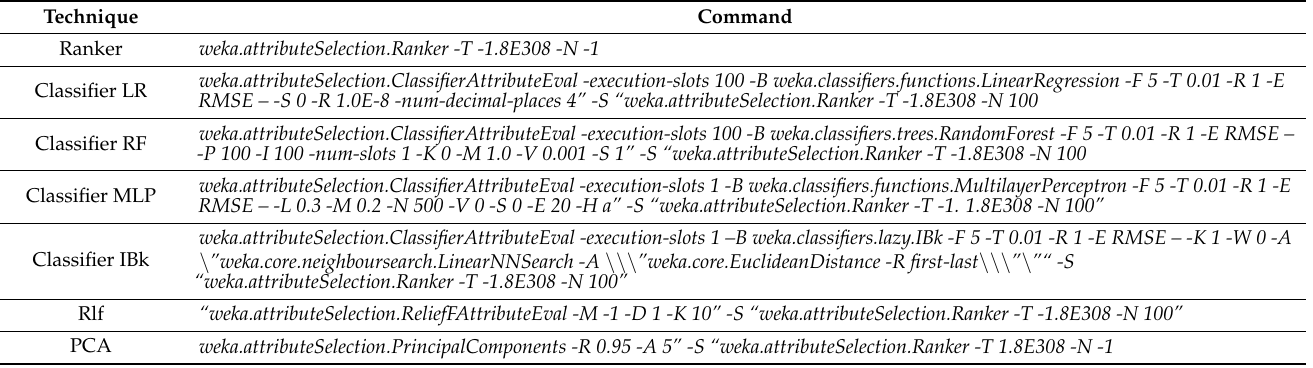
Table 3. WEKA commands for Feature Selection.